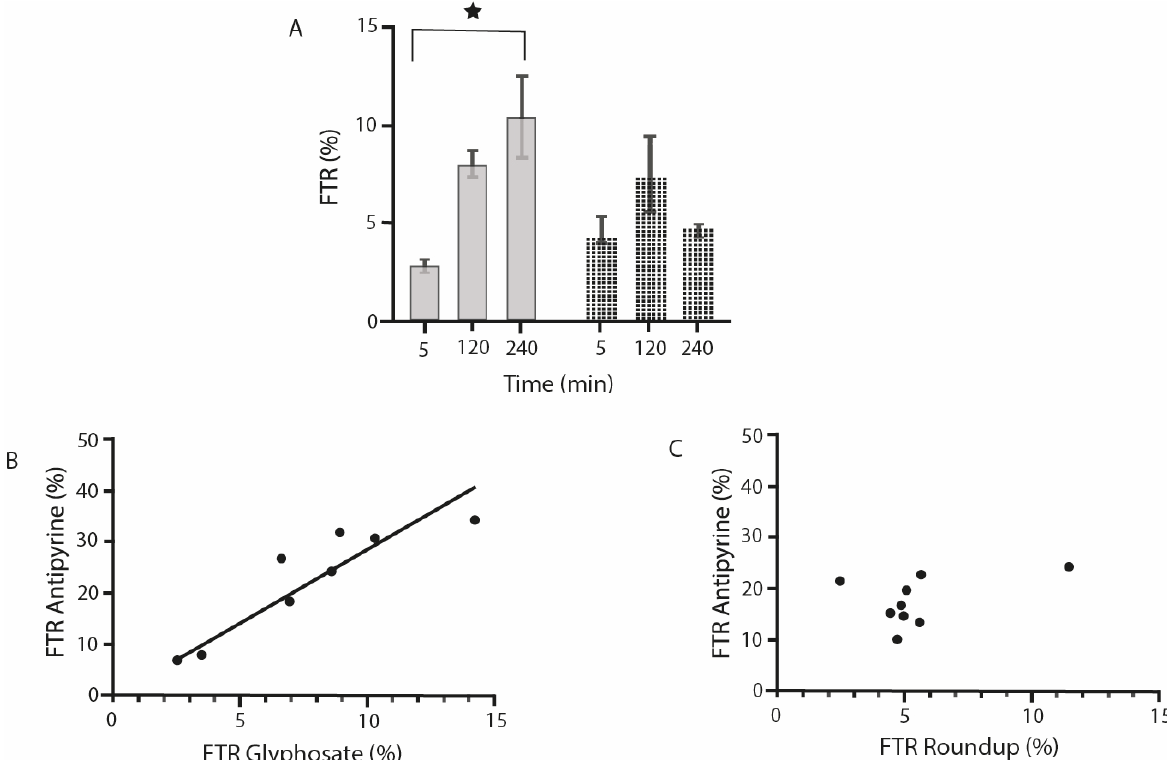
Figure 3. Fetal transfer rate of G alone or in its formulants (i.e., R) and correlations with antipyrine. ( A ) G + AMPAtransplacental transfer rate. G is measured by LC-MS-MS, together with its metabolite AMPA; values are given as mean ± SEM. ★ Significant difference p = 0.049. In grey: G alone; in dotted bars: G with formulants corresponding to R. ( B ) Correlation between A transfer rate and G transfer rate. For all times compiled r = 0.9039; p = 0.0021. ( C ) No real correlation between A transfer rate and R transfer rate. For all times compiled r = 0.403; p = 0.2811.